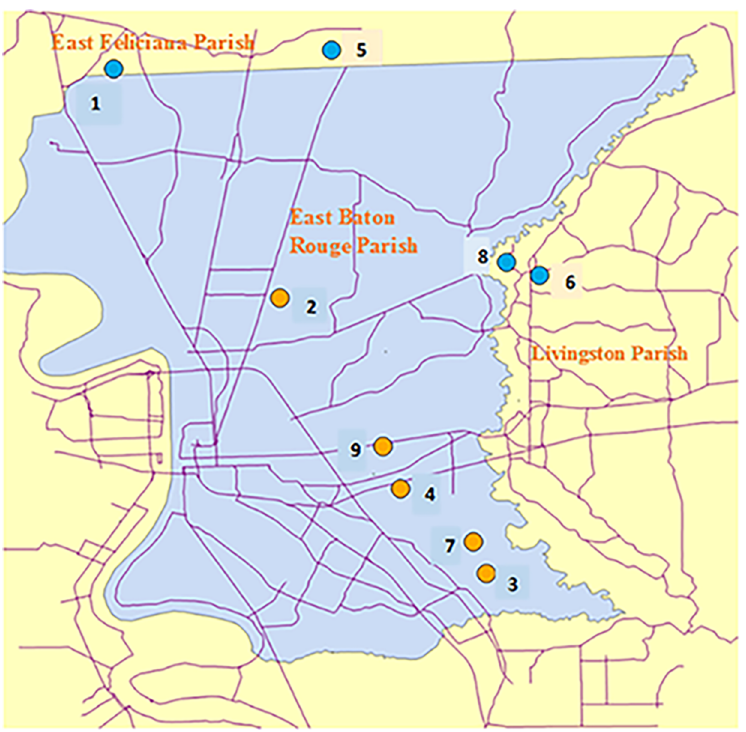
Fig 1. Experimental sites used for study. Blue circles represent control sites and orange circles represent treatment sites (ArcMap 10.2; ESR1).